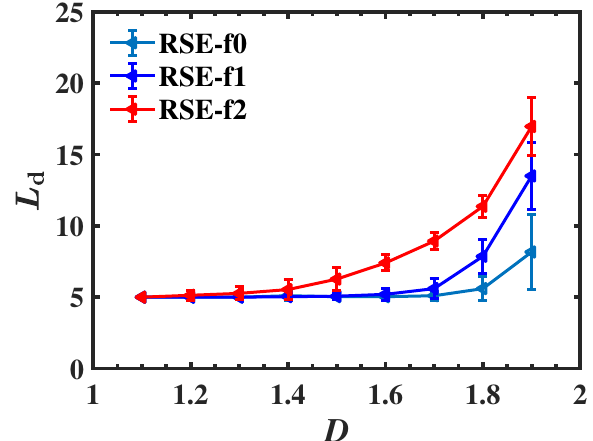
Figure 9. The average L d values under various flattening orders and D .